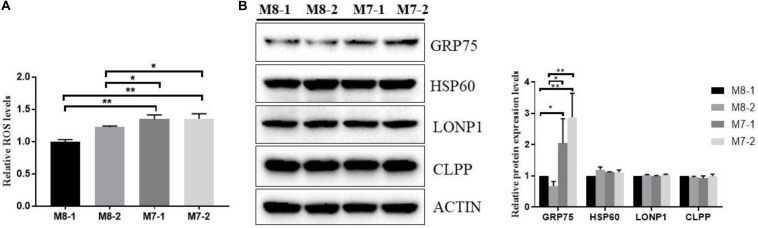
Mitochondrial oxidative stress is activated in M7 cybrids. (A) Mitochondrial ROS was determined in M8 and M7 cybrids by MitoSOX. Relative mitochondrial ROS levels were normalized to M8-1 cybrid. (B) Representative Western blot of mitochondrial quality control proteins, including GRP75, HSP60, LONP1, and CLPP, from whole-cell extracts of M8 and M7 cybrids. ACTIN was used as a loading control. Relative protein levels were normalized to M8-1 cybrid. Data are presented as the mean ± SD from at least 3 independent tests per experiment. *P < 0.05; **P < 0.01.